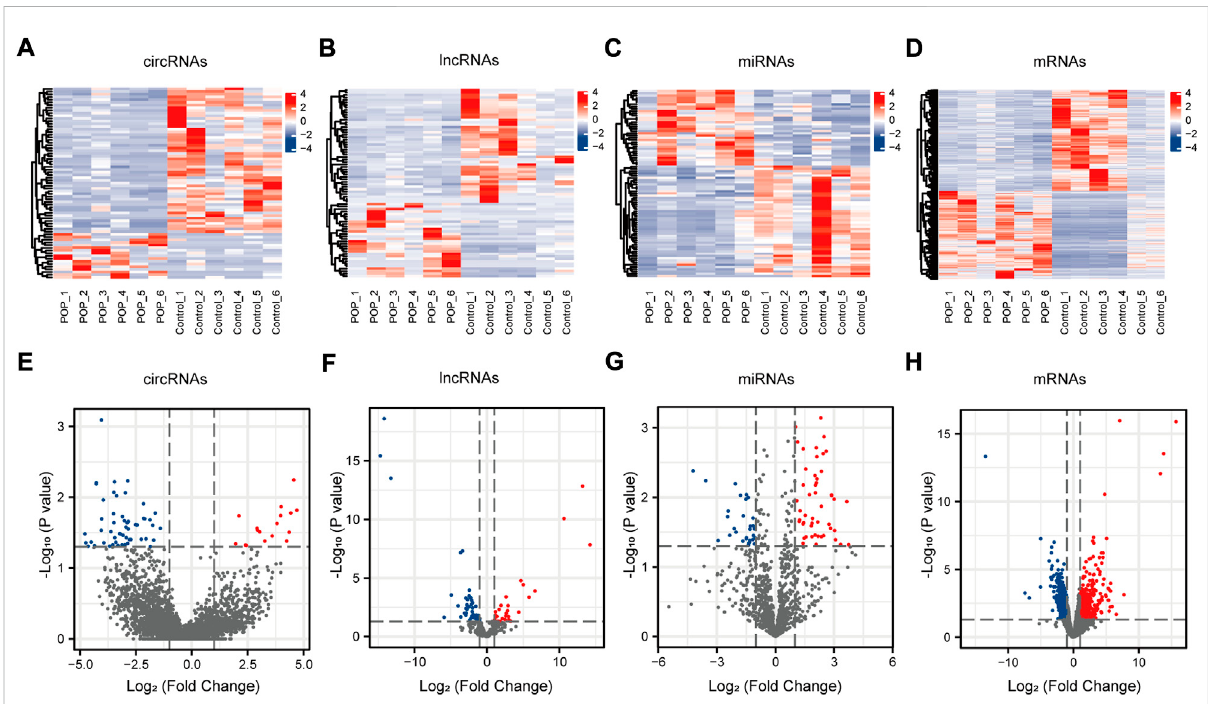
FIGURE 4 circRNA,lncRNA,miRNA,andmRNAexpressionpro fi les. (A – D) HeatmapsofDECs,DELs,DEMs,andDEGsintheanteriorvaginalwallinthePOP andcontrolgroups. (E – H) VolcanoplotsofDECs,DELs,DEMs,andDEGsintheanteriorvaginalwallinthePOPandcontrolgroups.POP,pelvicorgan prolapse; circRNA, circular RNA; lncRNAs, long noncoding RNAs; miRNA, microRNA; DECs, differentially expressed circRNAs; DELs, differentially expressed lncRNAs; DEMs, differentially expressed miRNAs; DEGs, differentially expressed